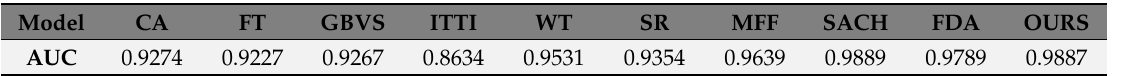
Table 2. The AUCs of our proposed model and nine competing models on Google Earth